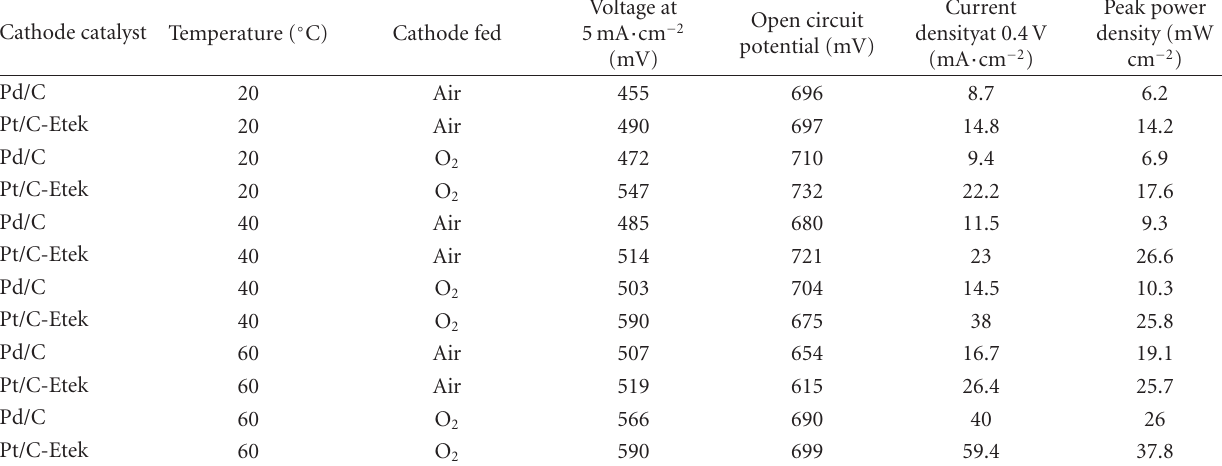
Table 3: Current densities at 0.4V, cell voltage at 5mA · cm − 2 , open circuit potential and peak power densities for a direct methanol fuel cell with 3M methanol solution fed to the anode at 20, 40, and 60 ◦